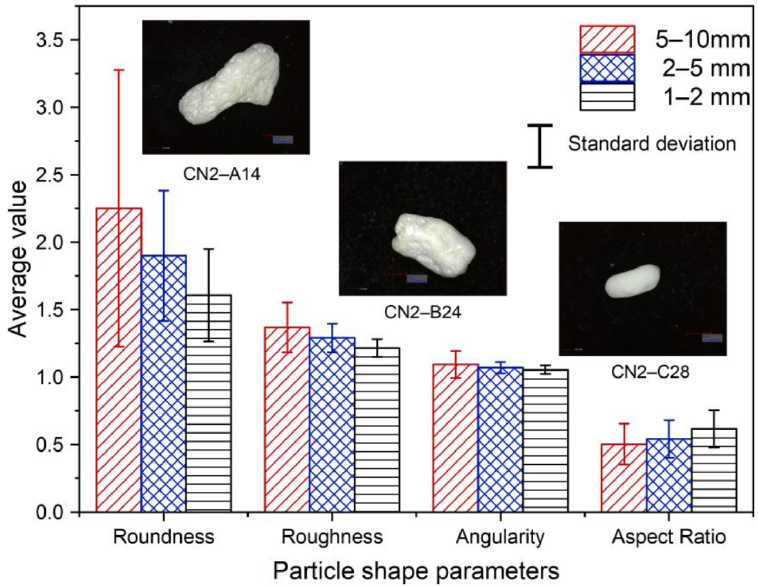
Figure 7. Average particle shape parameters against the mean grain size